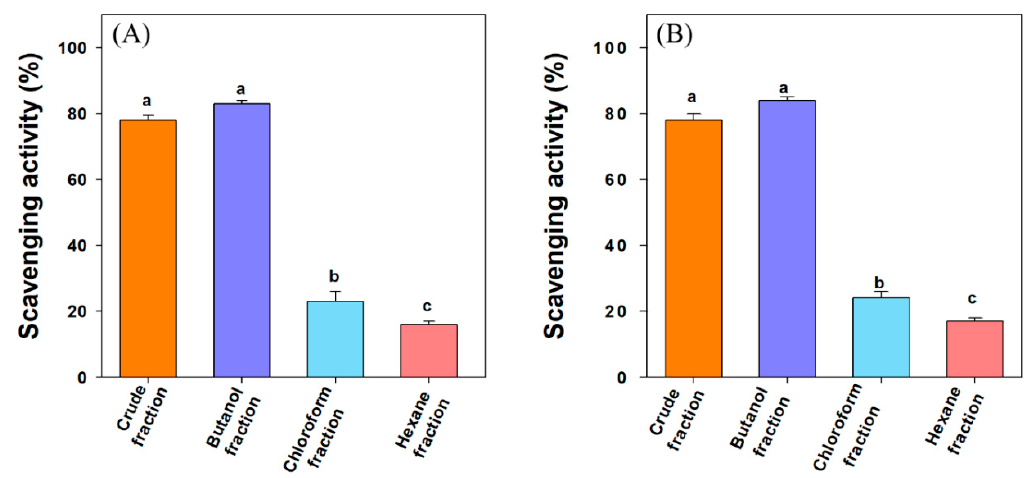
Comparison of ( A ) 2,2-diphenyl-1-picrylhydrazyl (DPPH) scavenging activity, and ( B ) 2,2 ′ -azino-bis(3-ethylbenzthiazoline-6-sulfonic acid) (ABTS) scavenging activity of N. oppositifolia crude extract and different fractions at 100 μ g/mL concentration. Data are presented as mean ± standard deviation values of triplicate determinations. Different superscripts letters (a–c) for a given value within the figure are significantly different from each other using Duncan’s multiple range test ( p < 0.05). Table 2. Comparison of DPPH and ABTS scavenging activity (IC 50 value) of di ff erent fractions and purified compounds (3-oxolupenal and katononic acid). Values are means of three experiments ± SD. The values followed by di ff erent superscript (a–d) di ff er significantly ( p < 0.05). Fractions / Compounds DPPH Scavenging Activity ( µ g / mL) ABTS Scavenging Activity ( µ g / mL) Crude extract 62.3 ± 5.3 a